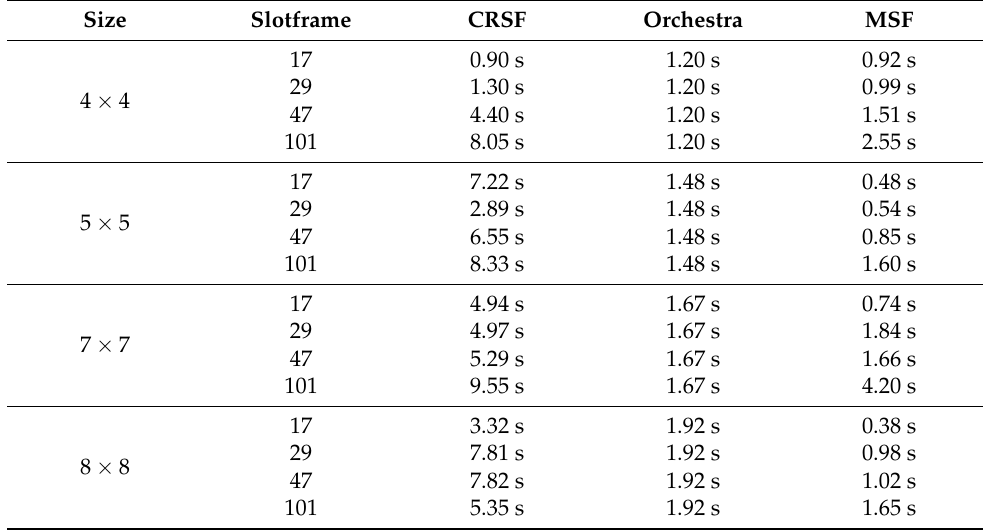
Table A2. Results for end-to-end latency (in seconds) with a periodic traffic